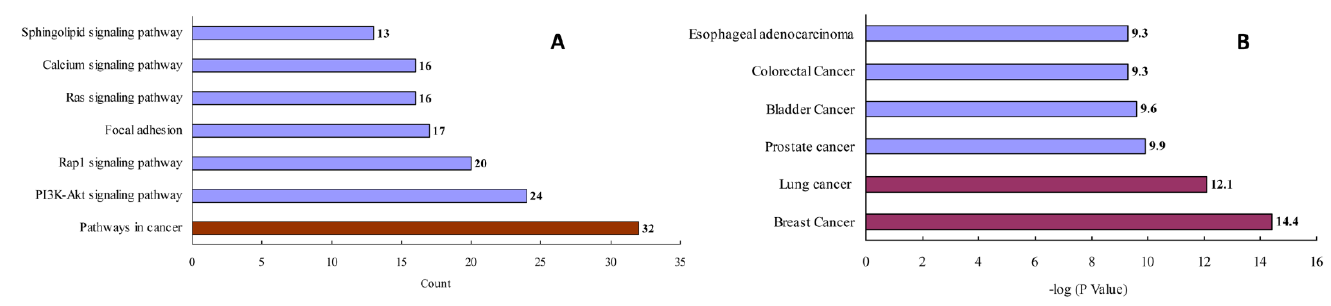
Figure 2. MS and MS/MS spectra of the biomarkers identified in P. quinquefolius from Wendeng: ( A ) ginsenoside Rb 3 ; ( B ) notoginsenoside R 1 ; ( C ) ginsenoside Rc.